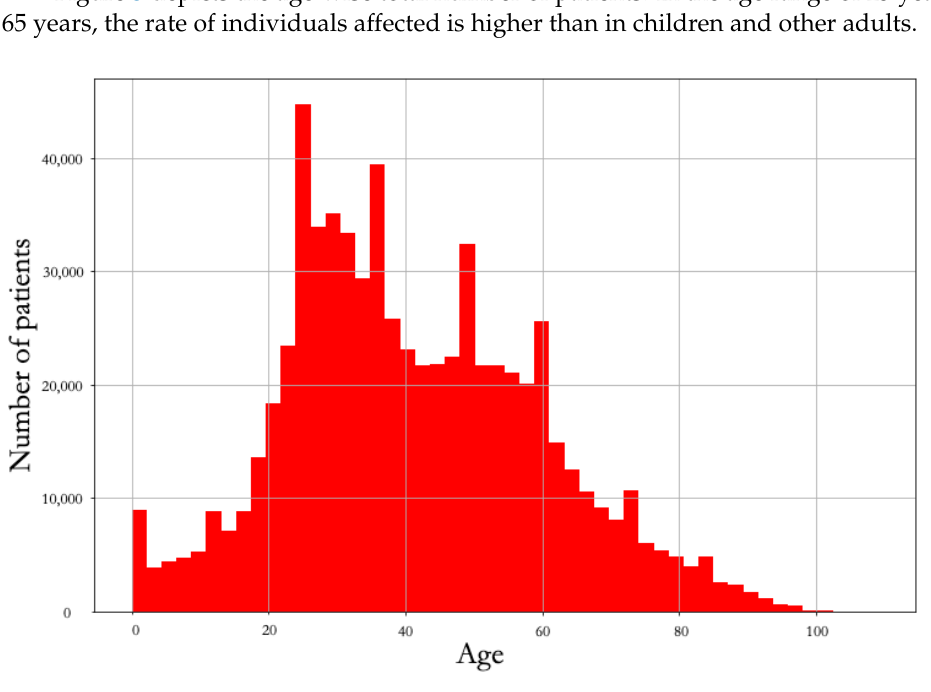
Figure 3. Distribution of confirmed patients by age. Figure 4 indicates the frequency of each symptom for all the patients, and Figure 5 describes the frequency for all the comorbidities.